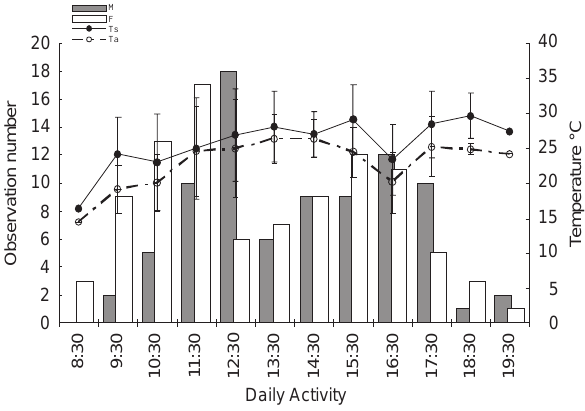
Figure 1. Daily activity pattern of males (black bar) and females (white bar) of Phymaturus palluma . Mean values and standard , dashed line) and substrate tem- deviation of air temperature (T a perature (T , solid line) are s